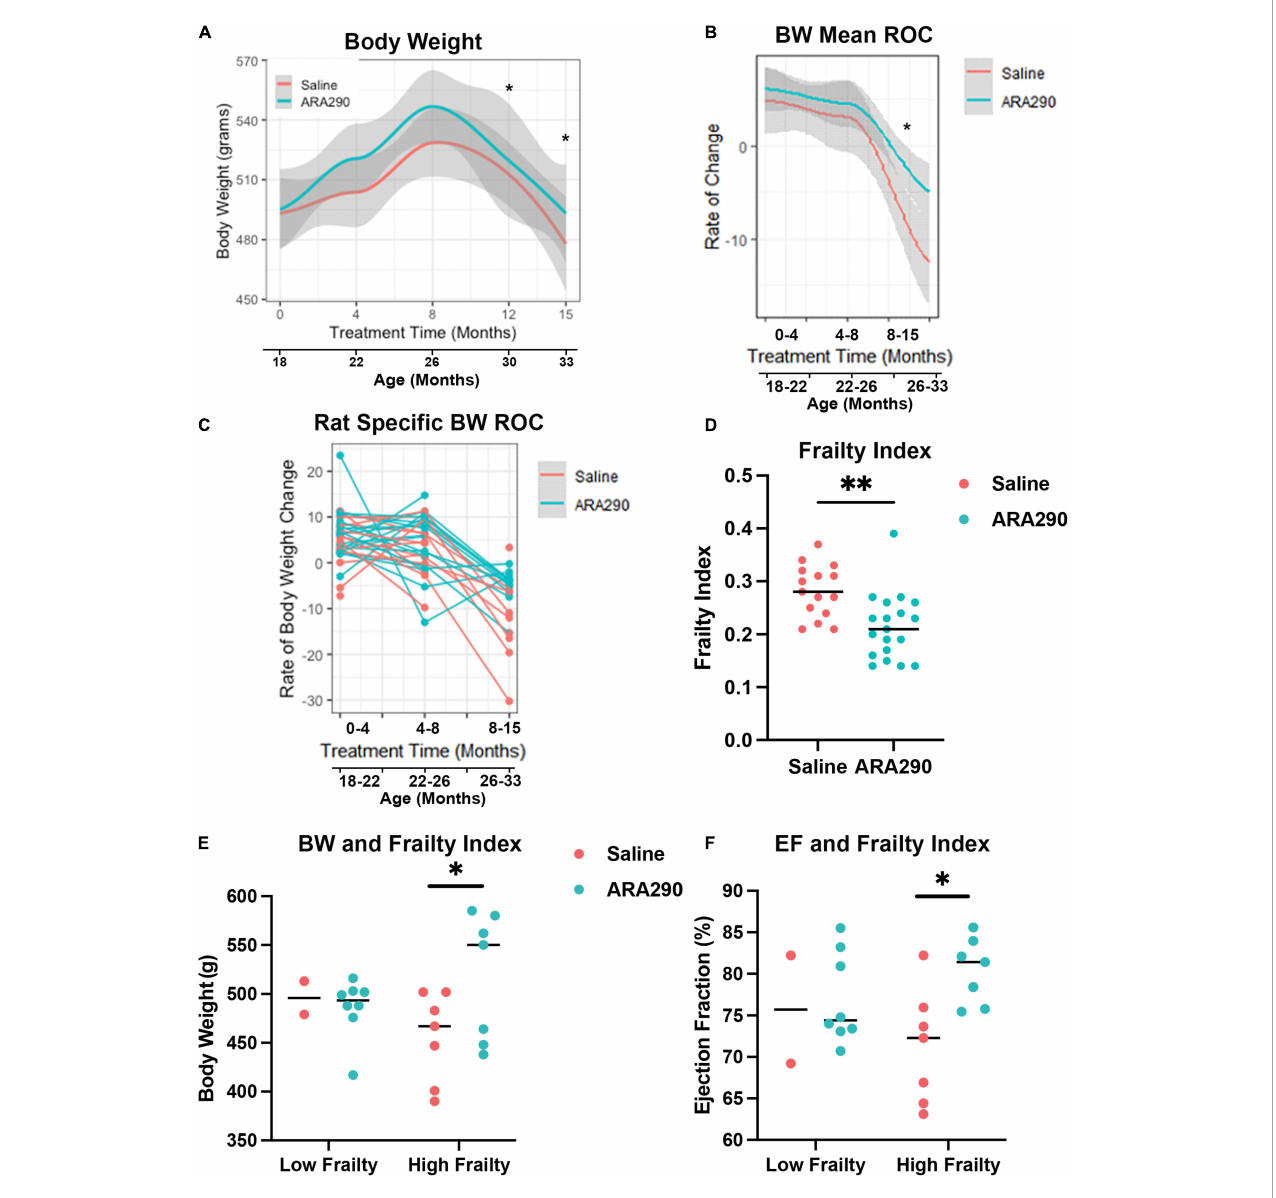
FIGURE4 Loess smooth curve (Red = Saline, Blue = ARA290) with 95% confidence intervals (gray) depicting the age-associated changes in body weight (A) , mean rate of change in body weight (B) , and rat-specific rate of change in body weight (C) . The frailty index for all rats at 33 months of age by treatment group (D) . Rat body weight and frailty category (frailty index score > 0.21) by treatment group (E) . Ejection fractions of rats by frailty category and treatment group (F) . Statistically significant interactions between treatment groups are shown ( ∗ P < 0.05, ∗∗ P <